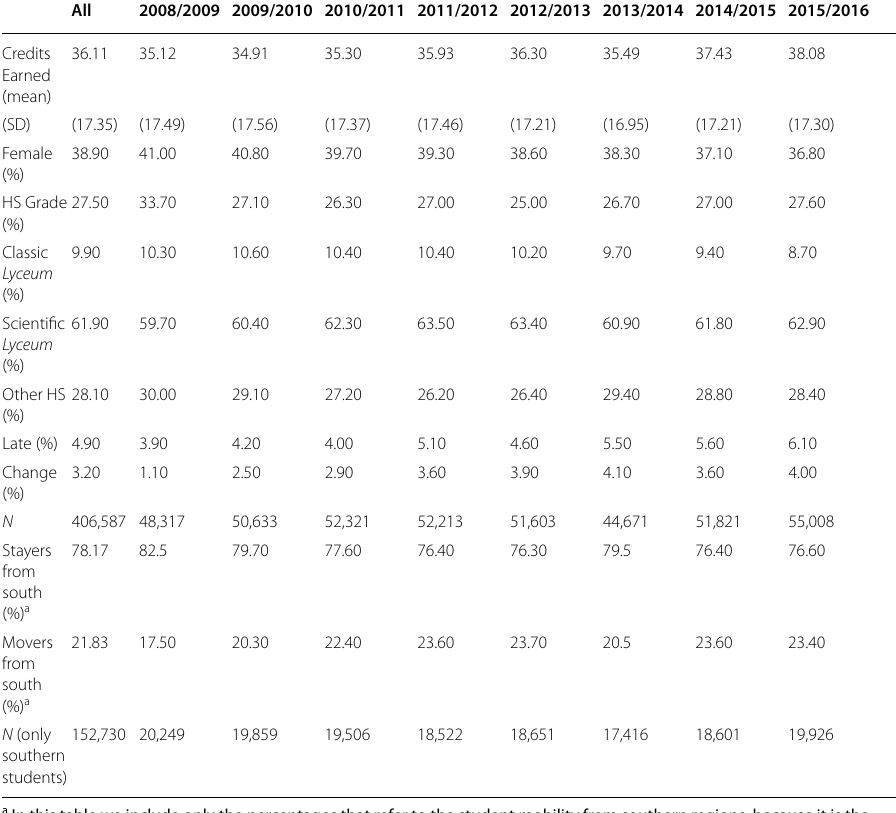
Table 2 Descriptive statistics of variables across academic